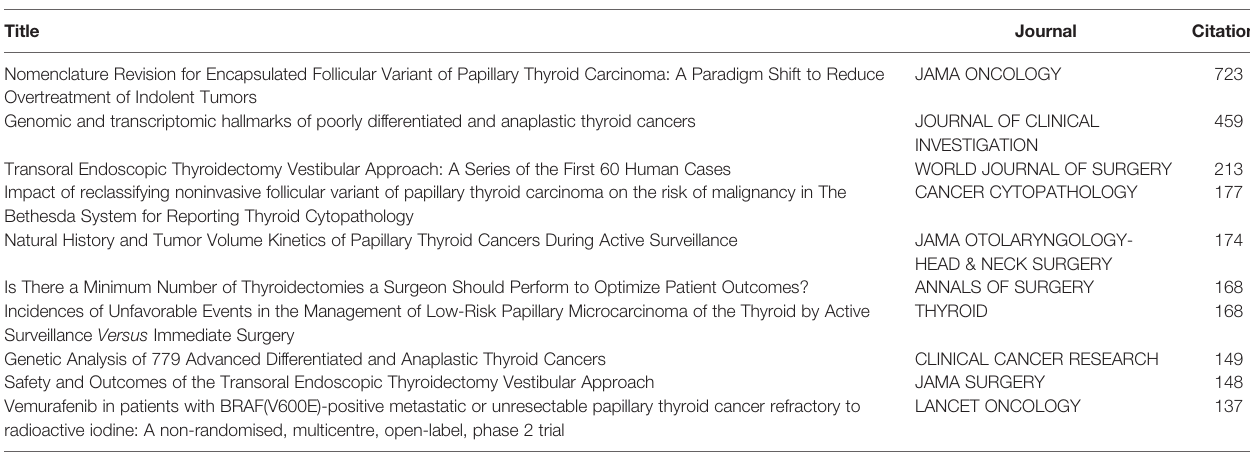
TABLE 2 | Top 10 most cited publications in the fi eld of thyroid